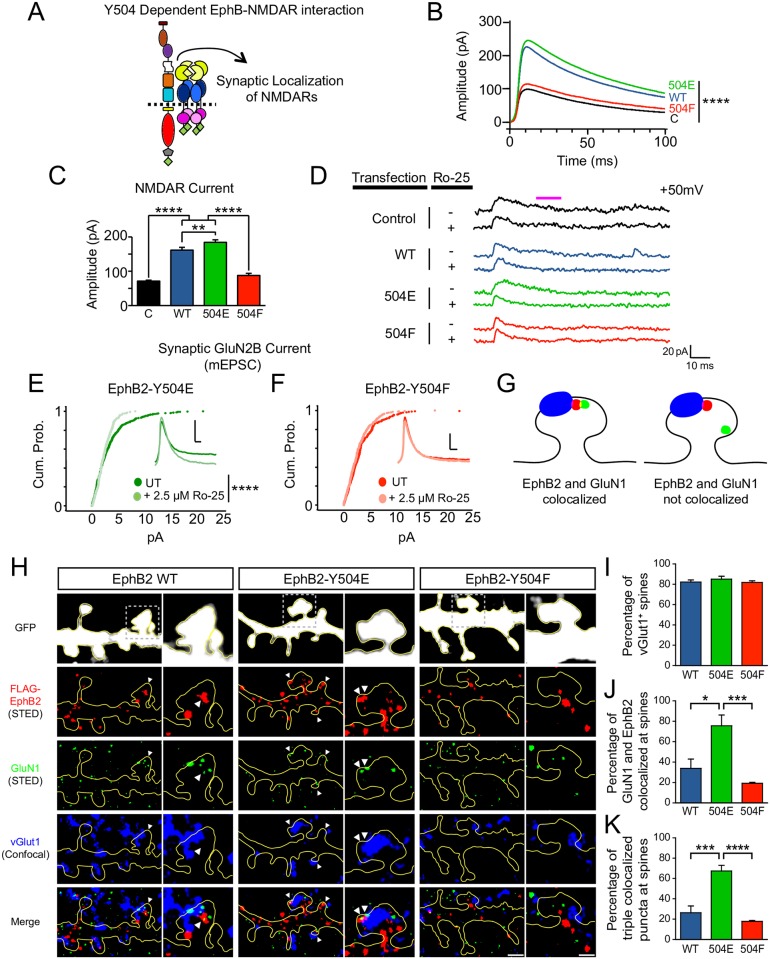
Synaptic currents and accumulation of N-methyl-D-aspartate receptors (NMDARs) at synaptic sites are controlled by phosphorylation of EphB2 Y504.(A) Experimental approach for the figure is illustrated. (B) Mean traces of whole-cell patch-clamp recording at 50 mV show the evoked and miniature excitatory postsynaptic currents (EPSCs) of primary rat cortical day in vitro (DIV) 21–23 neurons expressing enhanced green fluorescent protein (EGFP) without or with EphB2 wild type (WT) and Y504 mutants induced by light stimulation of neurons that express optogenetic light-sensitive channels (channelrhodopsin-2). (C) Effects of overexpression of EphB2 WT and Y504 mutants on the mean amplitude of evoked, spontaneous, and miniature EPSCs (30 milliseconds after the evoked EPSC peak) in mature cultured neurons. Overexpression of EphB2 WT or Y504E significantly increased amplitude of the NMDAR-dependent component of evoked EPSCs compared to the control or the Y504F mutant (****p < 0001, ANOVA followed by Fisher’s exact test, n = 375, 332, 581, and 200 events for control, EphB2 WT, Y504E, and Y504F, respectively). In addition, the amplitude of Y504E-overexpressing neurons was significantly higher than that of WT-overexpressing neurons (**p < 0.02, ANOVA followed by Fisher’s exact test). (D) Representative sample traces of whole-cell patch-clamp recording at 50 mV show that NMDAR-dependent currents in control neurons and neurons expressing EphB2 WT and Y504E, but not Y504F, are greatly reduced by GluN2B-specific antagonist Ro 25–6981 (Ro25). (E) Cumulative probability histogram of miniature EPSC (mESPC) amplitude for Y504E before and after application of Ro25 (2.5 μM). Inset: mean traces of mEPSCs after treatment with Ro25 (p < 0.001, Kolmogorov—Smirnov [K–S] test, n = 720 for Y504E and n = 427 for Y504E + Ro25). Vertical scale bar = 20 picoamperes (pA); horizontal scale bar = 10 milliseconds. (F) Cumulative probability histogram of mEPSC amplitude Y504F as in (E) (p = 0.0775, K–S test, n = 414 for Y504F and n = 404 for Y504F + Ro25). Vertical scale bar = 10 pA; horizontal scale bar = 10 milliseconds. (G) Model depicting 2 scenarios of VGLUT1 (blue), EphB2 (red), and GluN1 (green) localization at dendritic spines. (H) High-contrast images of dendrites of DIV 21 cortical neurons expressing EGFP, EphB2 short hairpin RNA (shRNA), and RNA interference (RNAi)-insensitive FLAG-tagged EphB2 WT, EphB2-Y504E, or EphB2-Y504F. Top panels show confocal EGFP staining (white), second panels show stimulated emission depletion (STED) EphB2 staining (red), third panels show STED GluN1 staining (green), fourth panels show confocal VGLUT1 (presynaptic marker) staining (blue), and bottom panels show merged images. White arrows indicate examples of triple colocalization of EphB2, GluN1, and VGLUT1. Scale bar = 1 μm, 0.5 μm inset. (I) Quantification of the effects of expression of EphB2 Y504 mutants on localization of VGLUT1 to dendritic spines in DIV 21 rat cortical neurons transfected at DIV 14. Graph shows fraction of spines containing VGLUT1 (not significant, ANOVA followed by Fisher’s exact test). (J) Quantification of the effects of expression of EphB2 Y504 mutants on colocalization with GluN1 in dendritic spines in DIV 21 rat cortical neurons transfected at DIV 14. Graph shows percentage of spines containing colocalized EphB2 and GluN1 puncta as defined by Fig 5G (*p < 0.05, ***p < 0.005, ANOVA followed by Fisher’s exact test). (K) Quantification of the effects of expression of EphB2 Y504 mutants on colocalization with GluN1 at synaptic sites in DIV 21 rat cortical neurons transfected at DIV 14. Graph shows percentage of spines containing triple colocalized puncta as defined by Fig 5G (***p < 0.005, ****p < 0.0005, ANOVA followed by Fisher’s exact test).